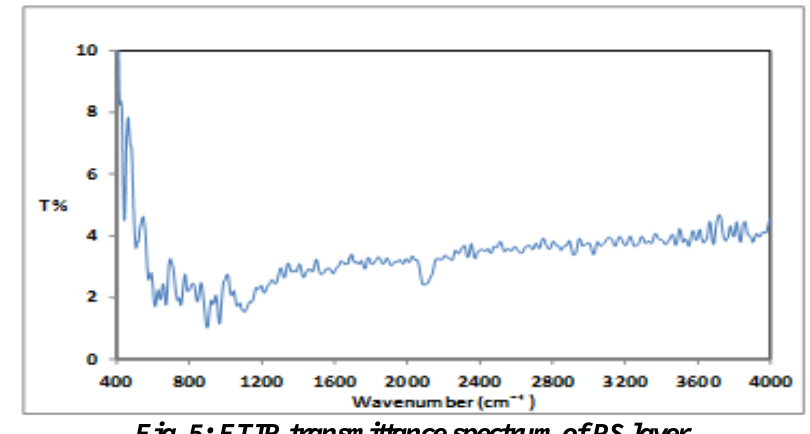
Fig. 5: FTIR transmittance spectrum of PS